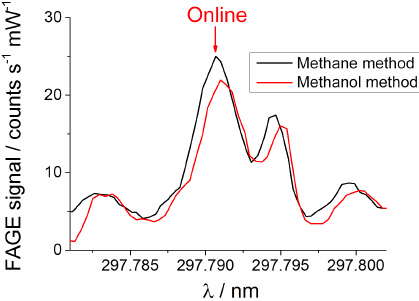
Figure 3. Typical laser excitation scans of CH 3 O performed over a much smaller range of wavelengths. Methoxy radicals were generated using OH and CH 4 (black line) to produce 5.5 × 10 10 moleculecm − 3 CH 3 O 2 , subsequently titrated to CH 3 O by adding NO, and the photolysis of methanol (red line) to generate 4.9 × 10 10 moleculecm − 3 CH 3 O directly. See main text for the de- scription of the methods and calibration. The signal was normalised for the laser power (10.3 ± 0.3mW in the methane method and 8.7 ± 0.2mW in the methanol method). Fluorescence cell pressure = 2.65 ± 0.05Torr; wavelength increment (cid:49)λ = 10 − 3 nm, with each point corresponding to 5000 laser shots. The red arrow in- dicates the wavelength λ (online) ∼ 297.79nm used for the time- resolved kinetic studies of CH 3 O 2 .